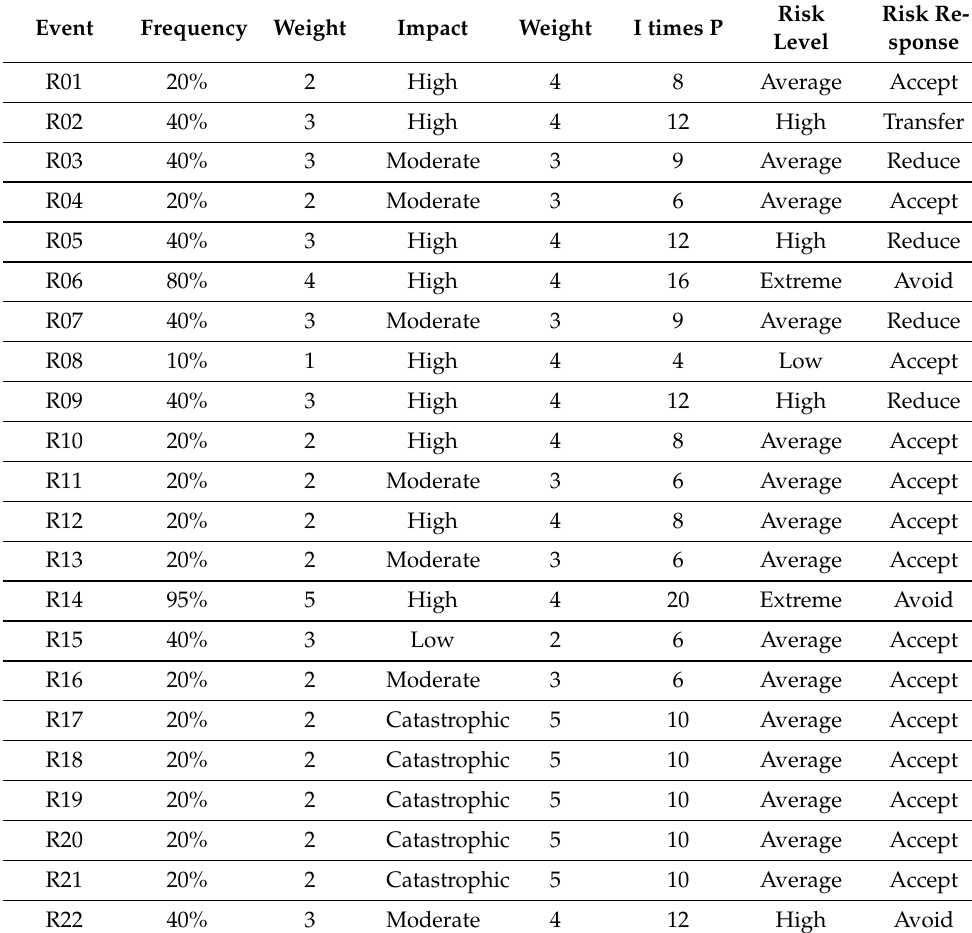
Table 3. Risk Assessment of the Provide ICT Infrastructure